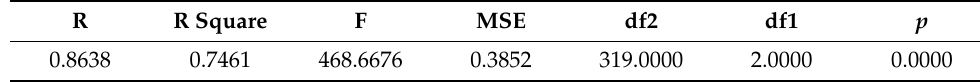
Table 13. The Model Summary (b and ´c).